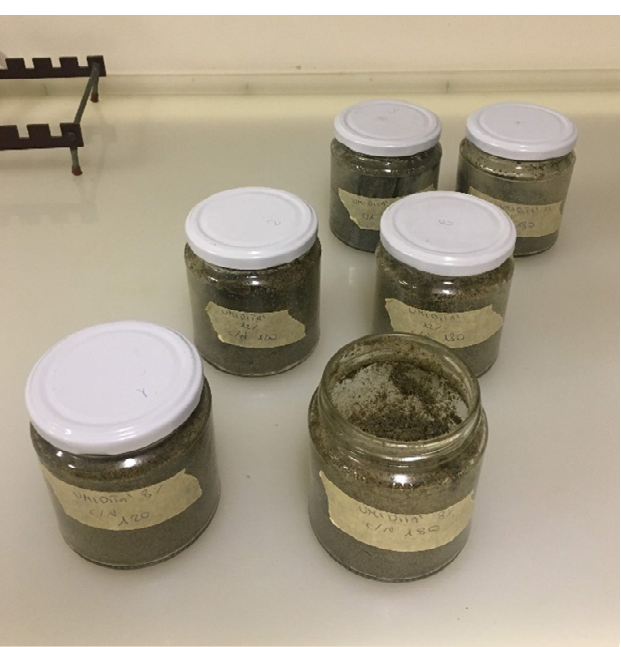
Figure 2. Contaminated soil microcosms.